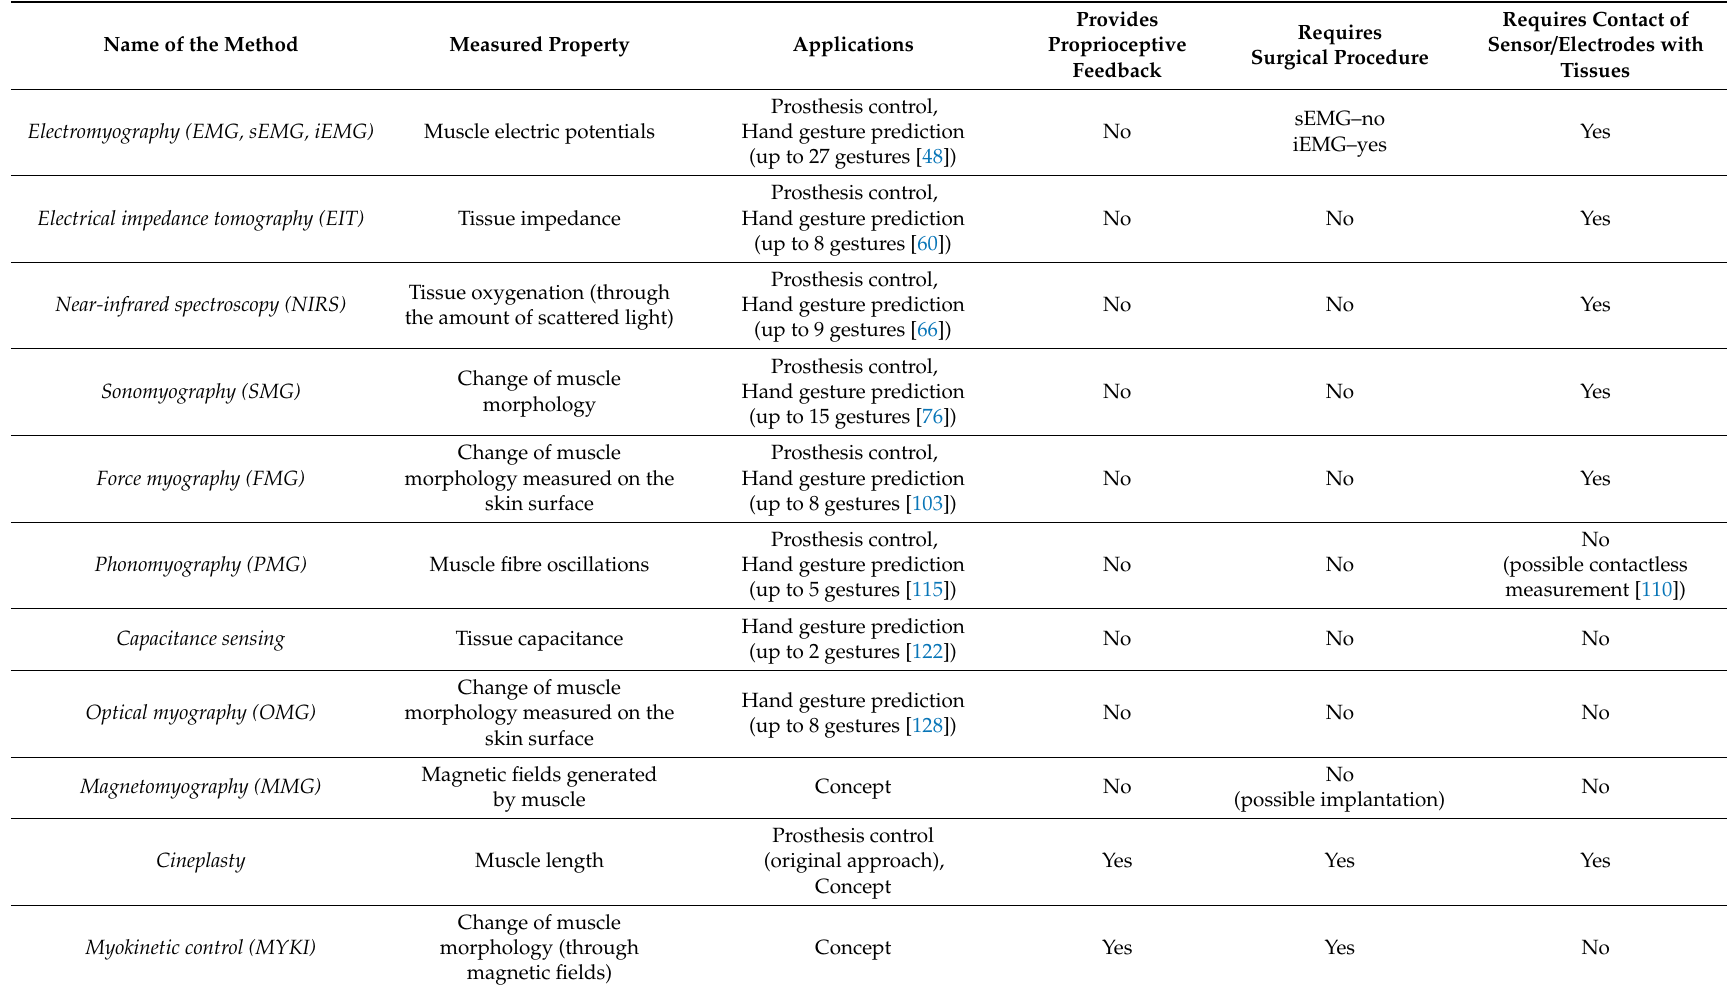
Table 1. Comparative overview of the control